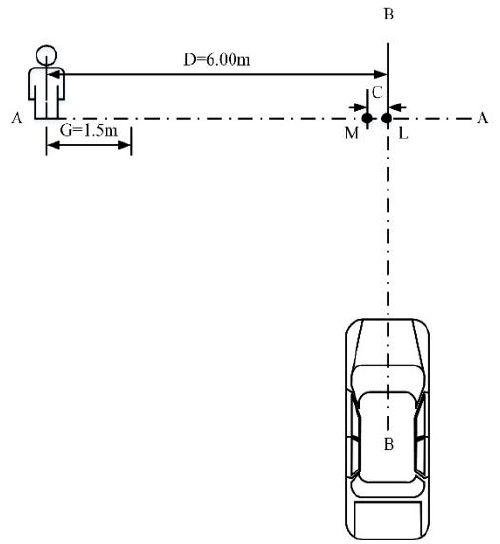
Sensors 2019 , 19 , x Figure 21. The CVNA (Car ‐ to ‐ VRU Nearside Adult) ‐ 25 andCVNA ‐ 75 (near ‐ end). Figure 21. The CVNA (Car-to-VRU Nearside Adult)-25 andCVNA-75 (near-end).